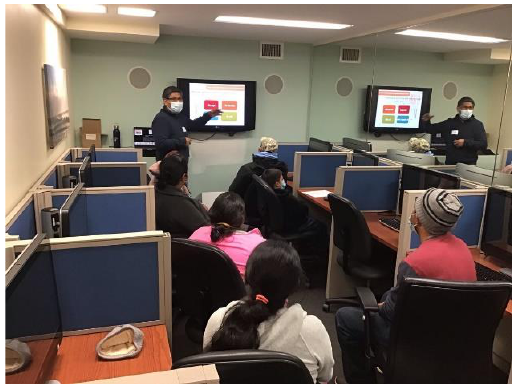
Figure 5. Parents